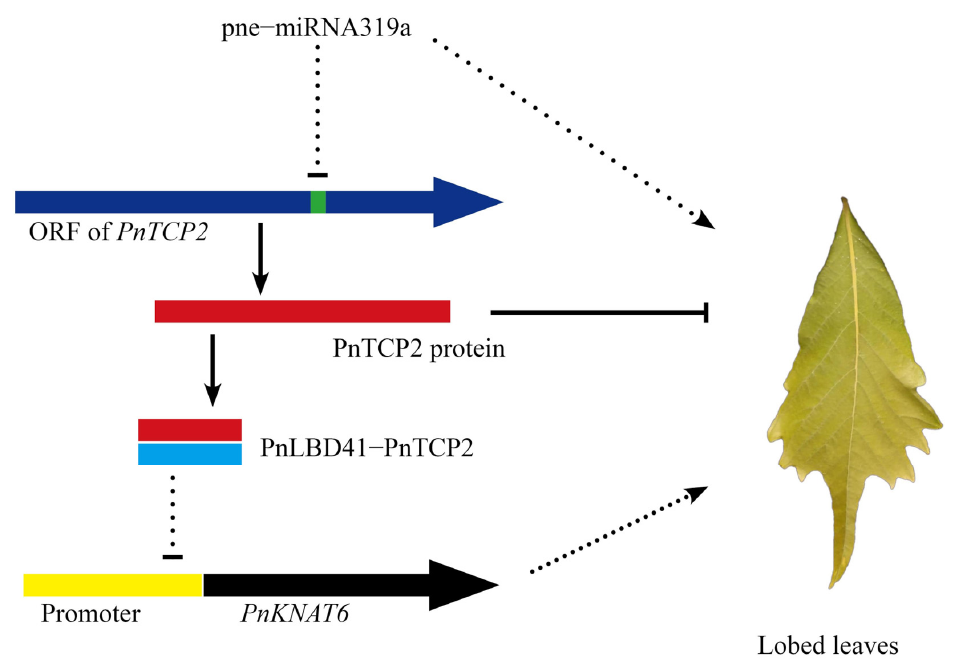
Figure 6. Theoretical schematic diagram of PnTCP2 regulating the formation of leaf margin lobes in P. neurantha var. lobophylla. Arrows and arrowheads indicate regulatory effects. Lines with terminal bars indicate repressive effects. The regulatory relationship represented by dotted lines comes from previous reports and has not been verified in this study.